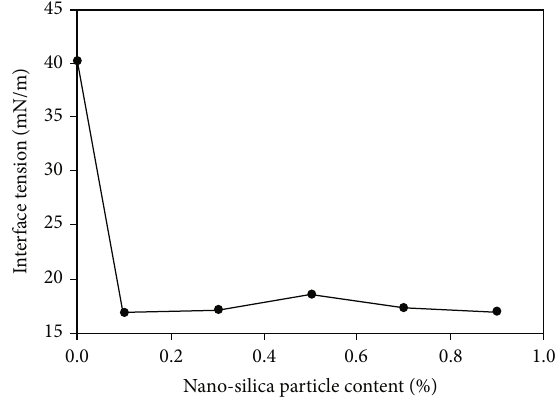
Figure 4: Relationship between nanosilica particle content and interface tension.